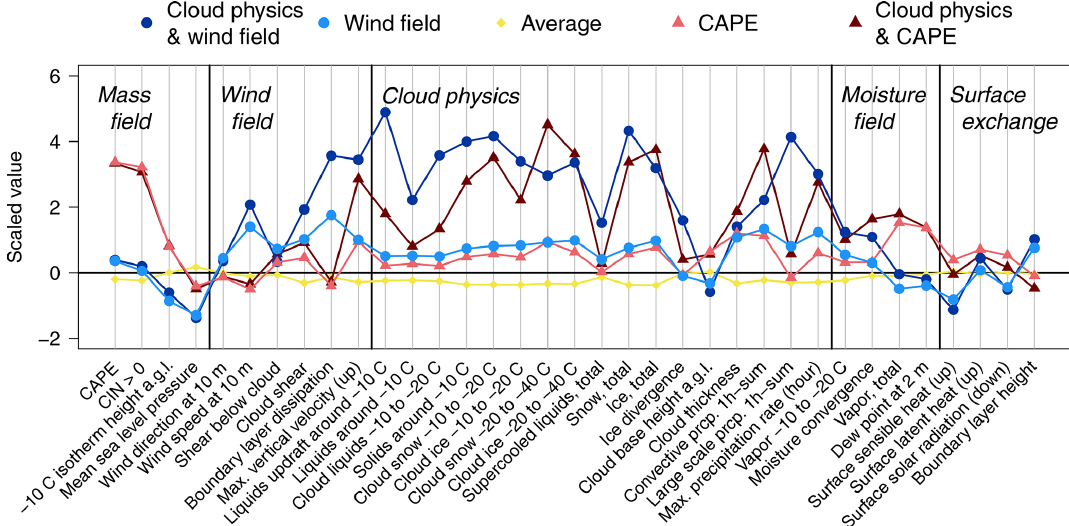
Figure 4. Cluster means (color-coded) of scaled ERA5 variables arranged by physical categories (italics). Variables are transformed by the square root and standardized to a mean of 0 and a standard deviation of 1 based on the scenarios without